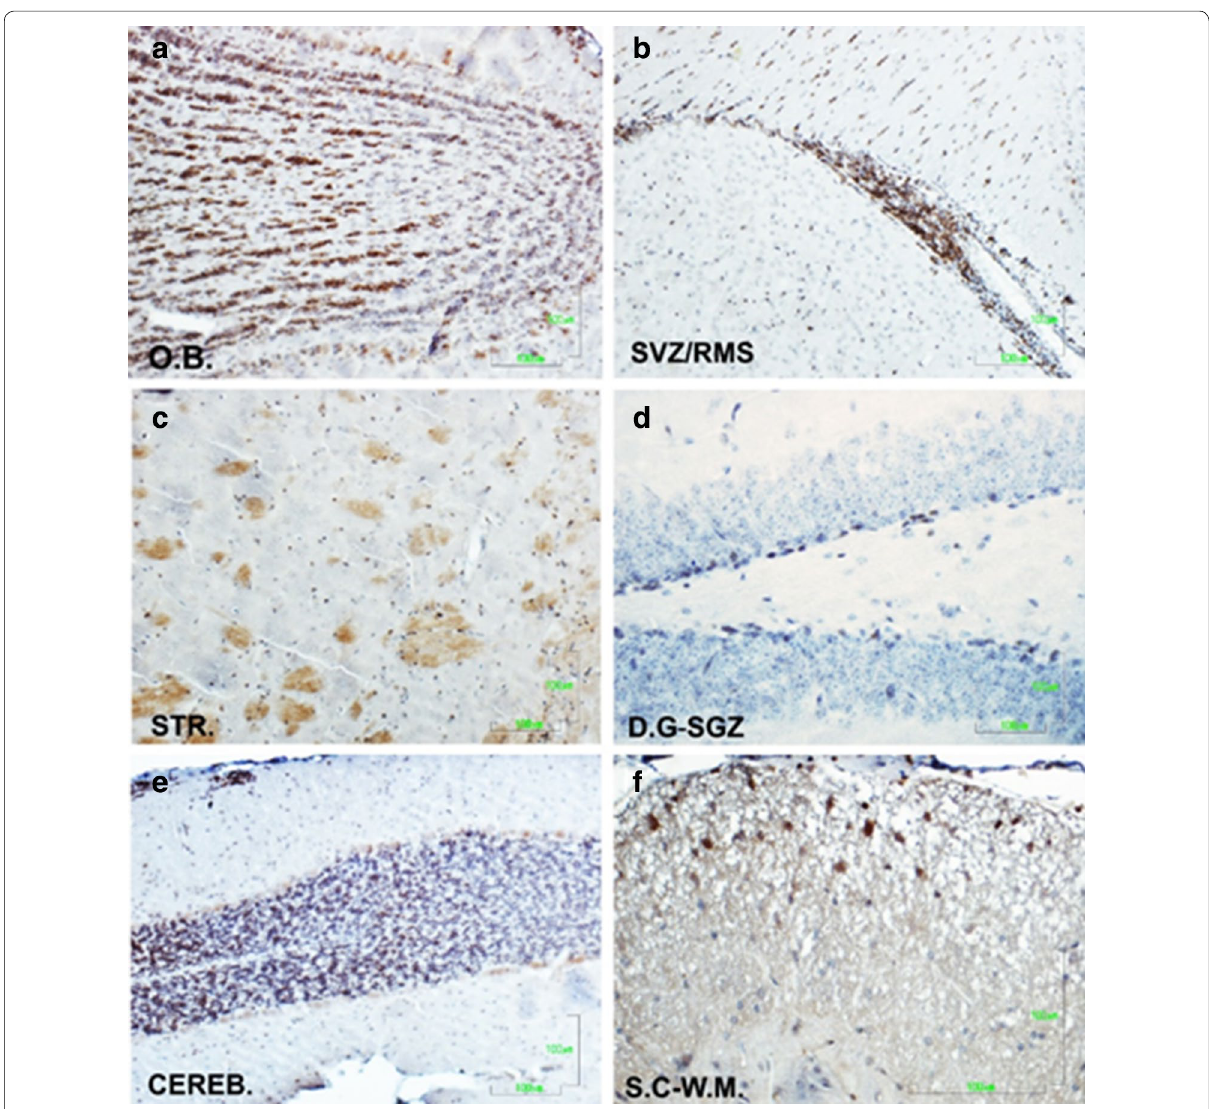
Fig. 4 Immunohistochemistry of different mouse brain and spinal cord regions using Fab 65 crude extract as primary antibody. Cells expressing antigens recognized by Fab 65 are stained brown. a O.B.: olfactory bulb, b SVZ/RMS: subventricular zone/rostral migratory stream of the SVZ, c STR.: striatum, d D.G-SGZ: subgranular zone of the dentate gyrus, e CEREB.: cerebellum, f S.C-W.M.: white matter of the spinal cord. Scale bars